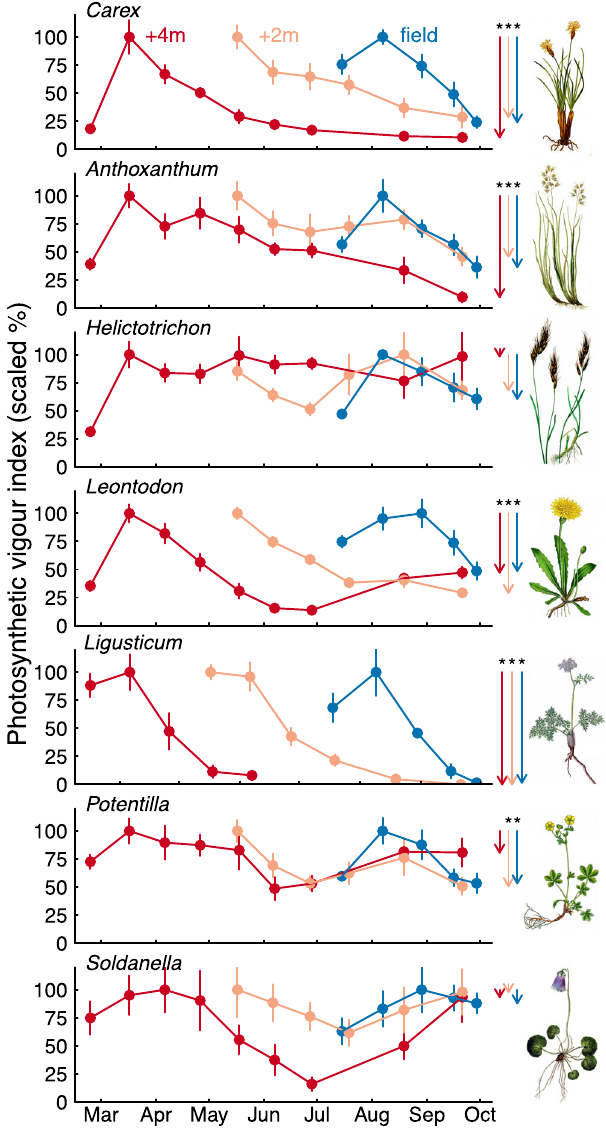
Fig. 4 | Maintenance of photosynthetically active tissue in the seven most abundant species over the season. Species-speci fi c photosynthetic vigour index (mean±SE)wascalculated fromnumber,size, greenarea,and chlorophyllcontent ofleaves,inmonoliths(+2m,+4m)and fi eldplots.Dataarescaledtopercentofthe maximumperspeciesandgroup.Valueswereassessedforthesame1 – 3individuals per experimental unit (8 monoliths for +4m, +2m, and 5 fi eld plots) across the season. Arrows on the right side highlight the difference between the maximum and the last value of theseason withinthe corresponding group.Asterisksindicate P <0.05(two-sided t tests,detailedstatisticsinSupplementaryTable2).Fullspecies names are in Table 2. Illustrations provided by Oliver